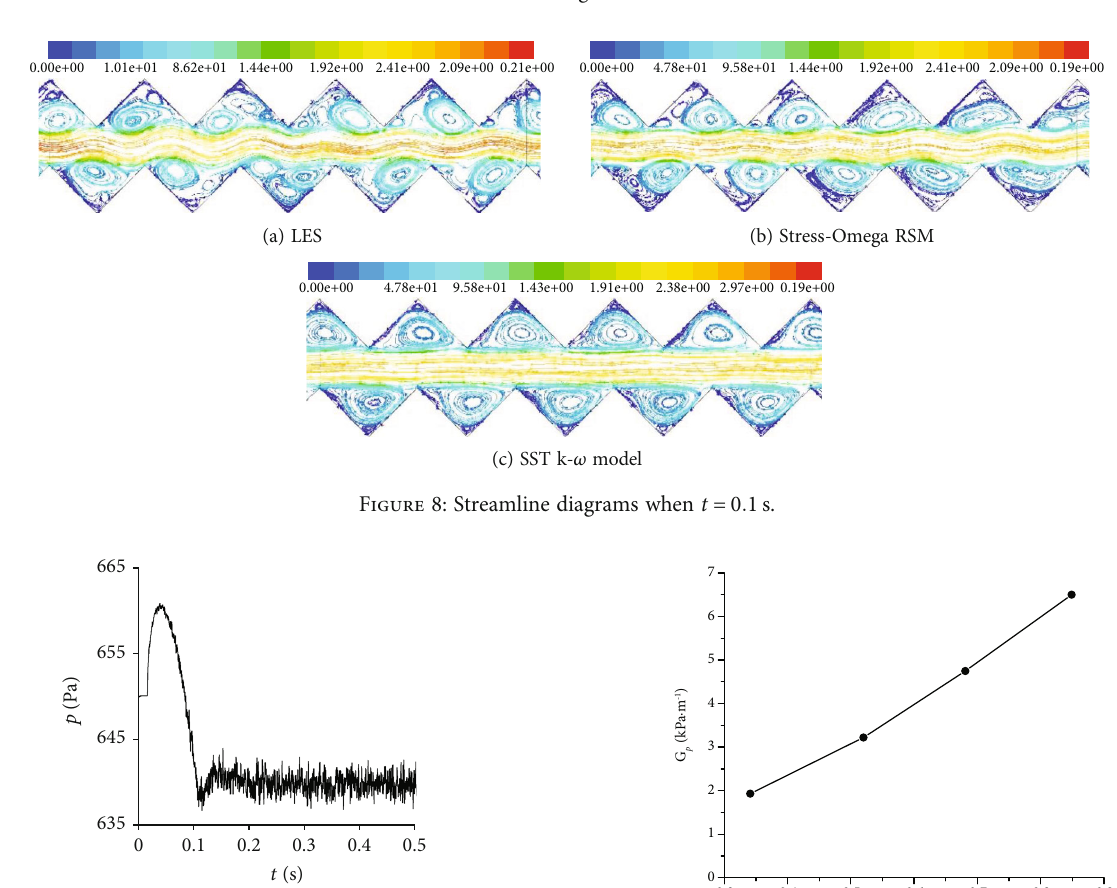
Figure 7: Streamline diagrams when t = 0 : 06 s .